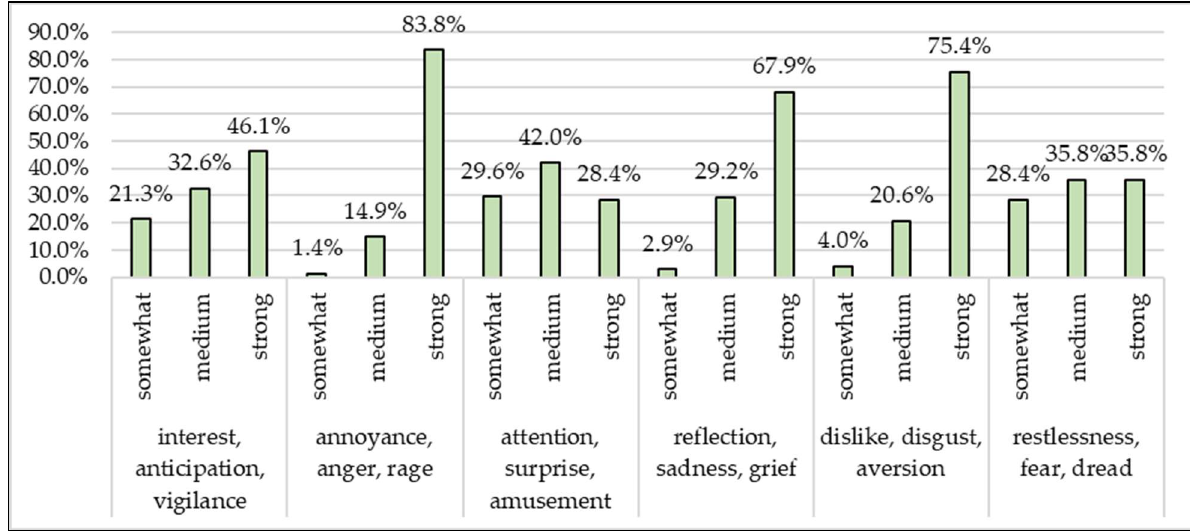
Figure 8. What emotion is activated in animal welfare activists when someone causes suffering to an animal and to what degree? ( n = 150).